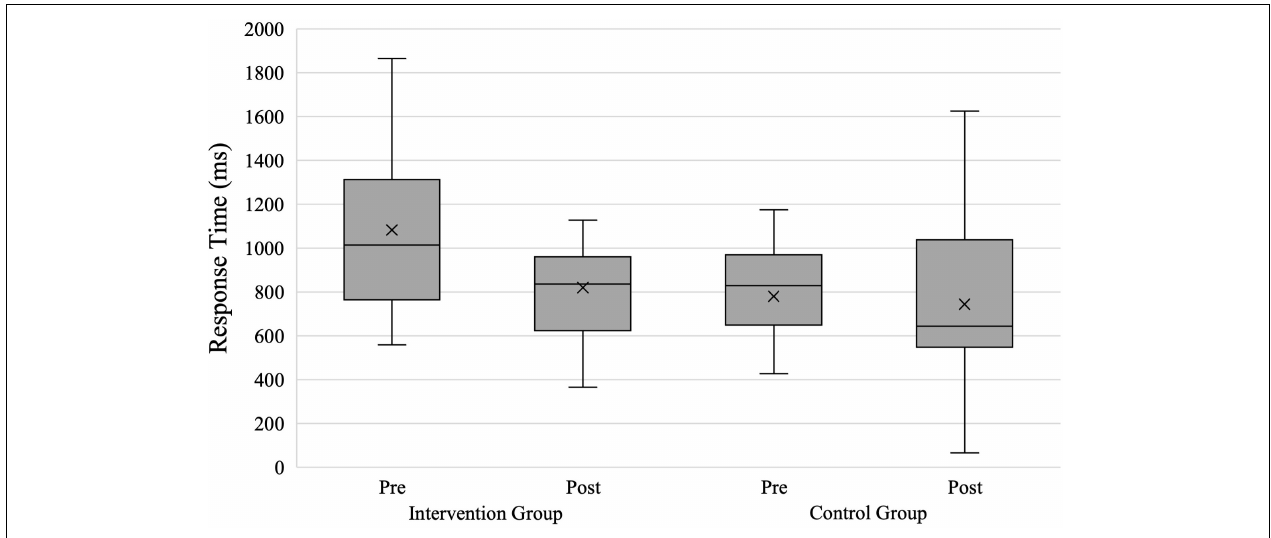
FIGURE 6 | Response Time in shoot scenarios for both groups. X, mean